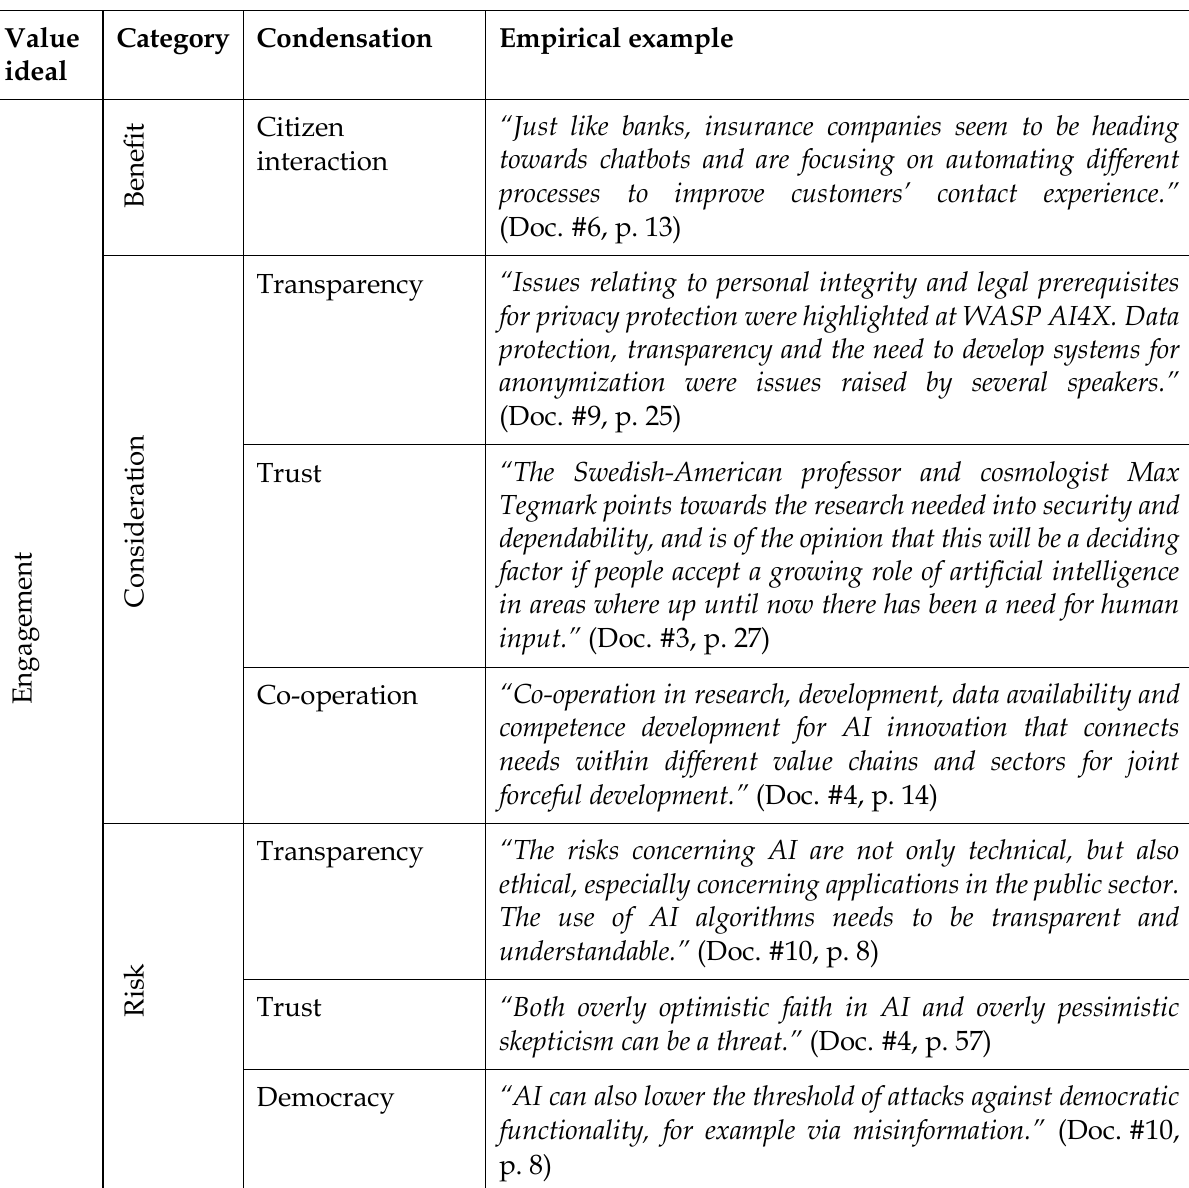
Table 7. Empirical examples of condensations and their categorie s for the ‘Engagement’ value